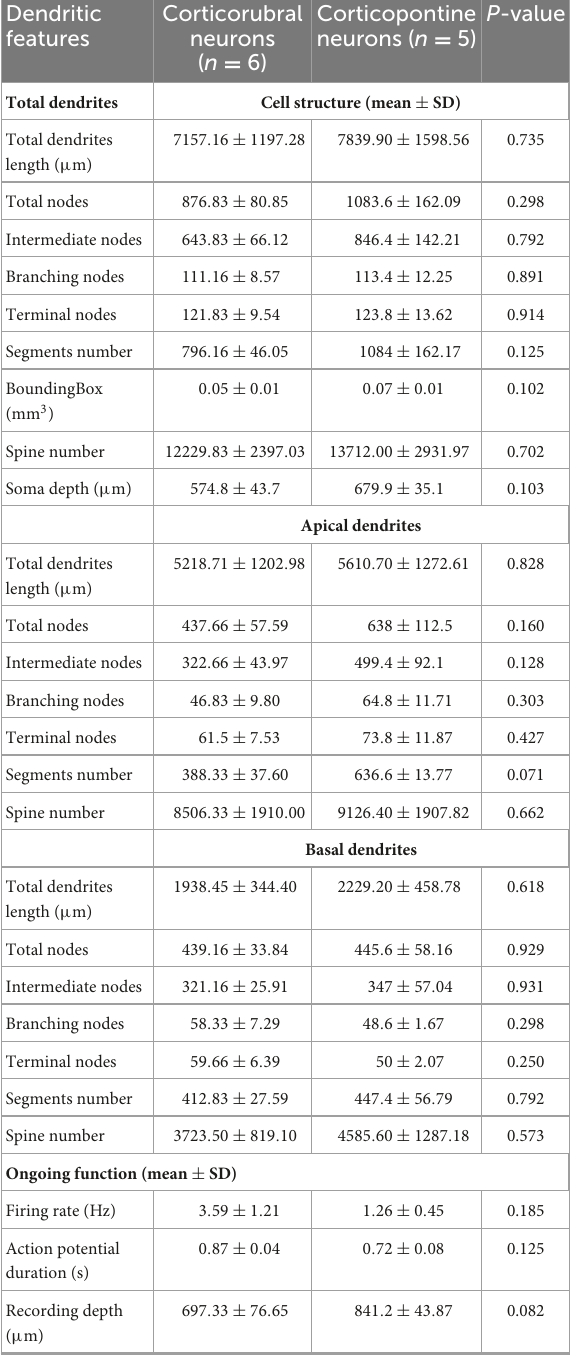
TABLE 2 Total characteristics of the projection neurons to red nucleus and pons. Dendritic